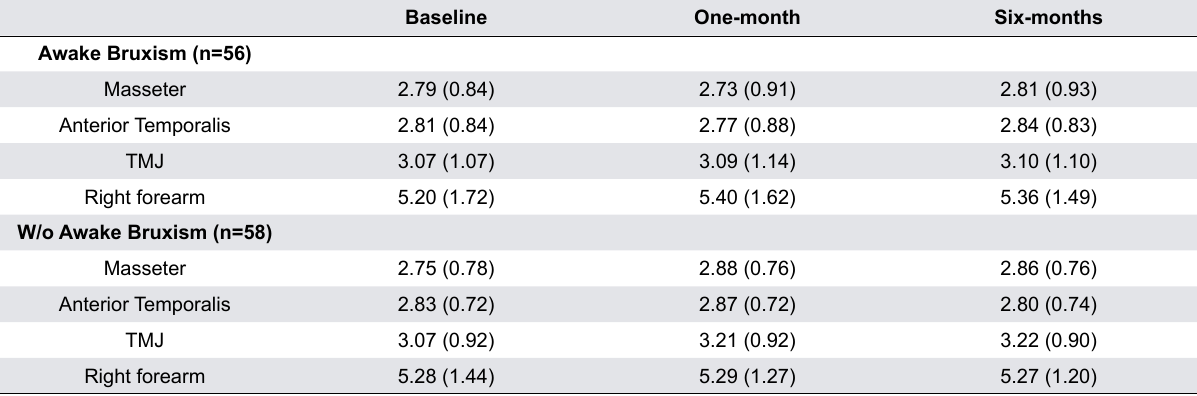
Table 1- Mean and standard deviation (SD) of the pressure pain threshold (PPT) of masseter, anterior temporalis, temporomandibular joint (TMJ), and right forearm throughout the study follow-up